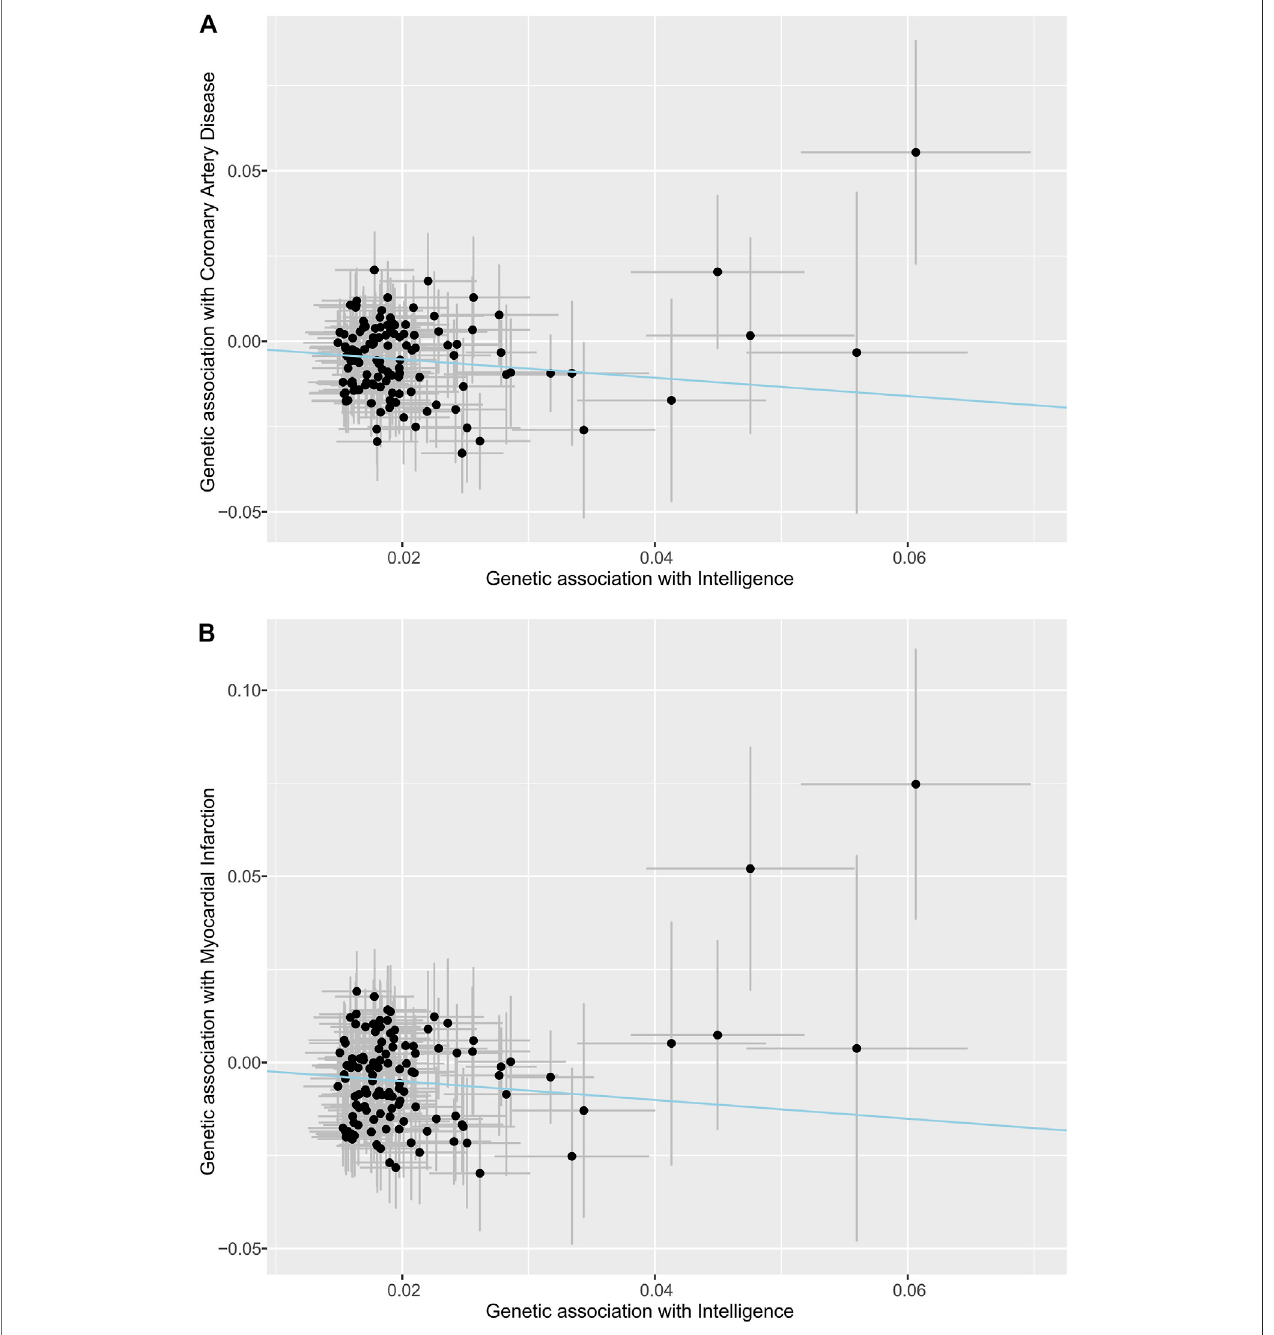
FIGURE1| Associationsofintelligence-relatedvariantswithoutcomes. (A) Coronaryarterydisease. (B) Myocardialinfarction.Thedotsindicatethecausaleffectof each SNP. The bars indicate the 95% con fi dence intervals. The blue line indicates the estimate of effect using the inverse-variance weighted method.